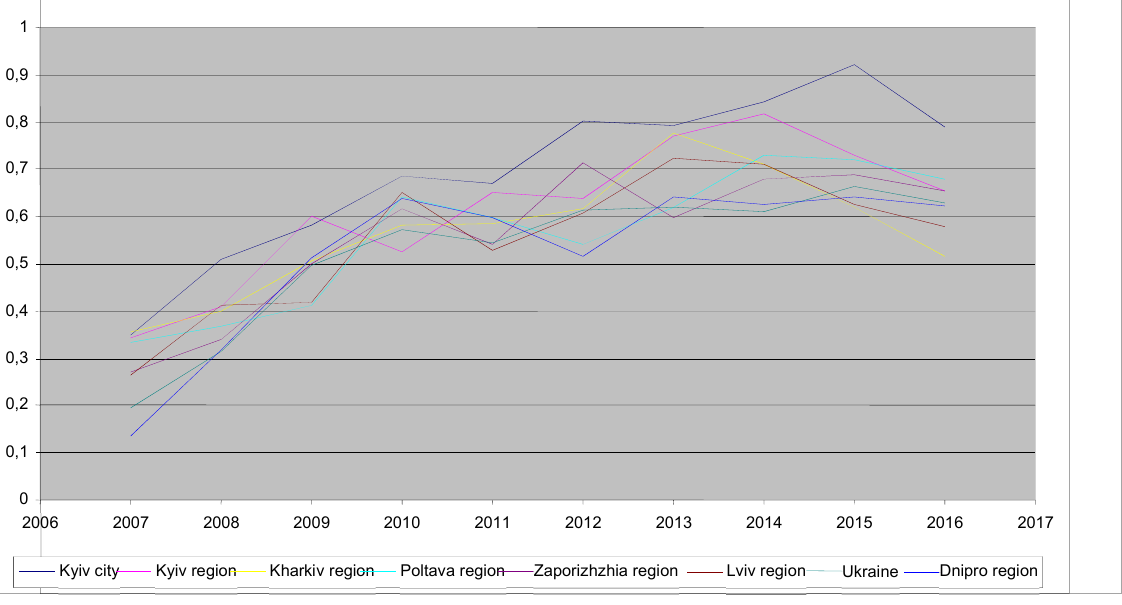
Fig. 1. Dynamics of the modified level of regional development with an average value of the integral indicator more than